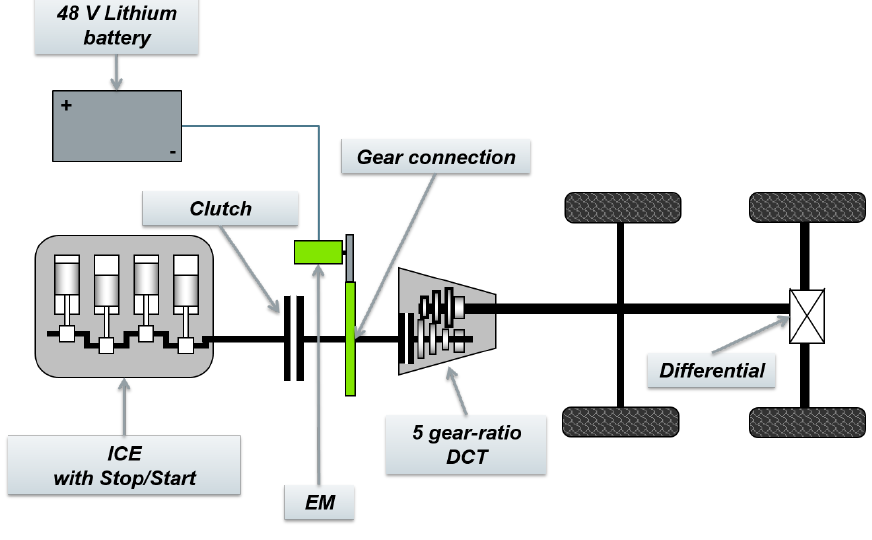
Figure 1. Studied